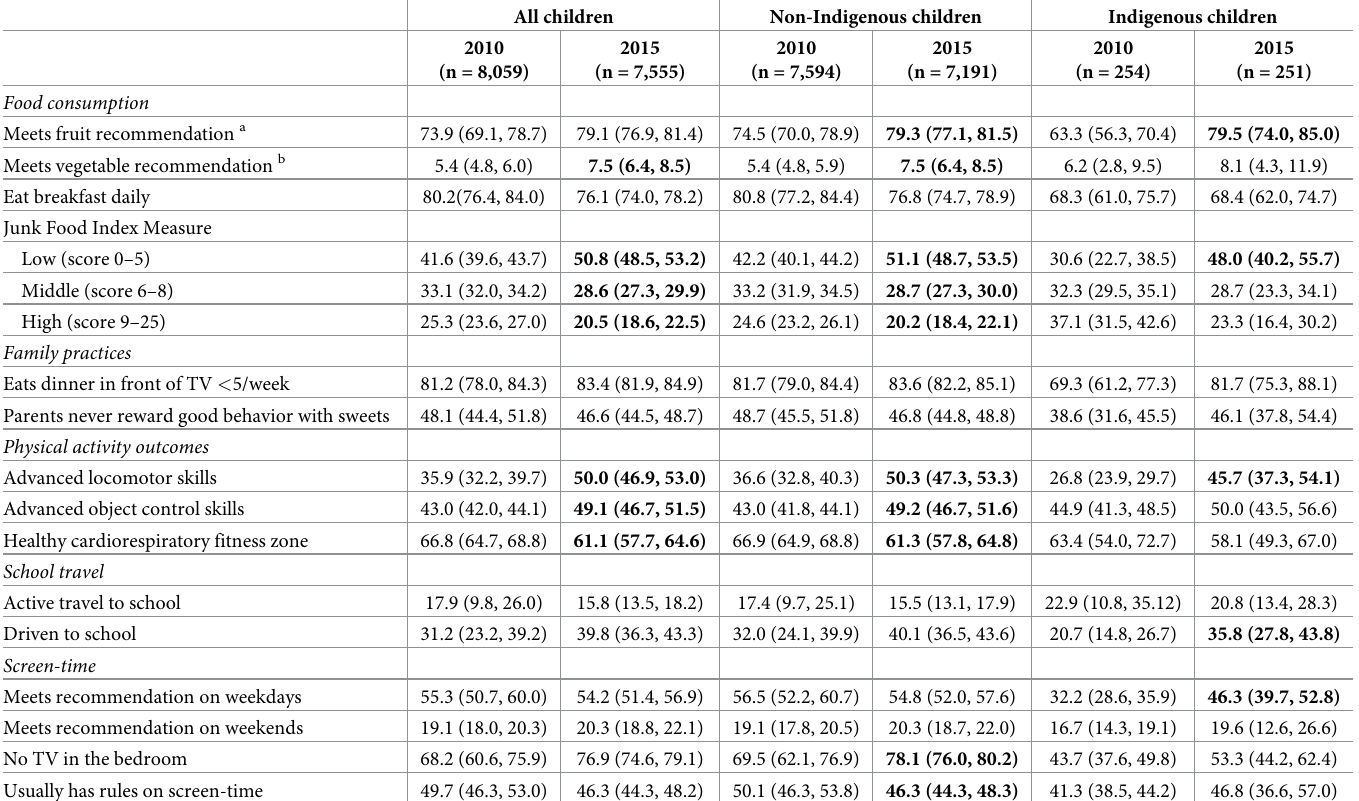
Table 2. Adjusted prevalence of weight-related behaviors by child group and survey year (%; 95%CI).